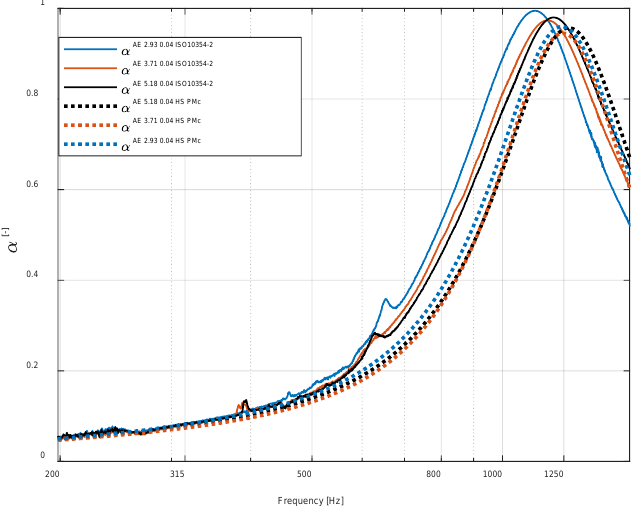
Figure 11. Cross-validation results of normal incidence sound absorption for 4 cm specimens with the different Aggregate/Cement ratios .